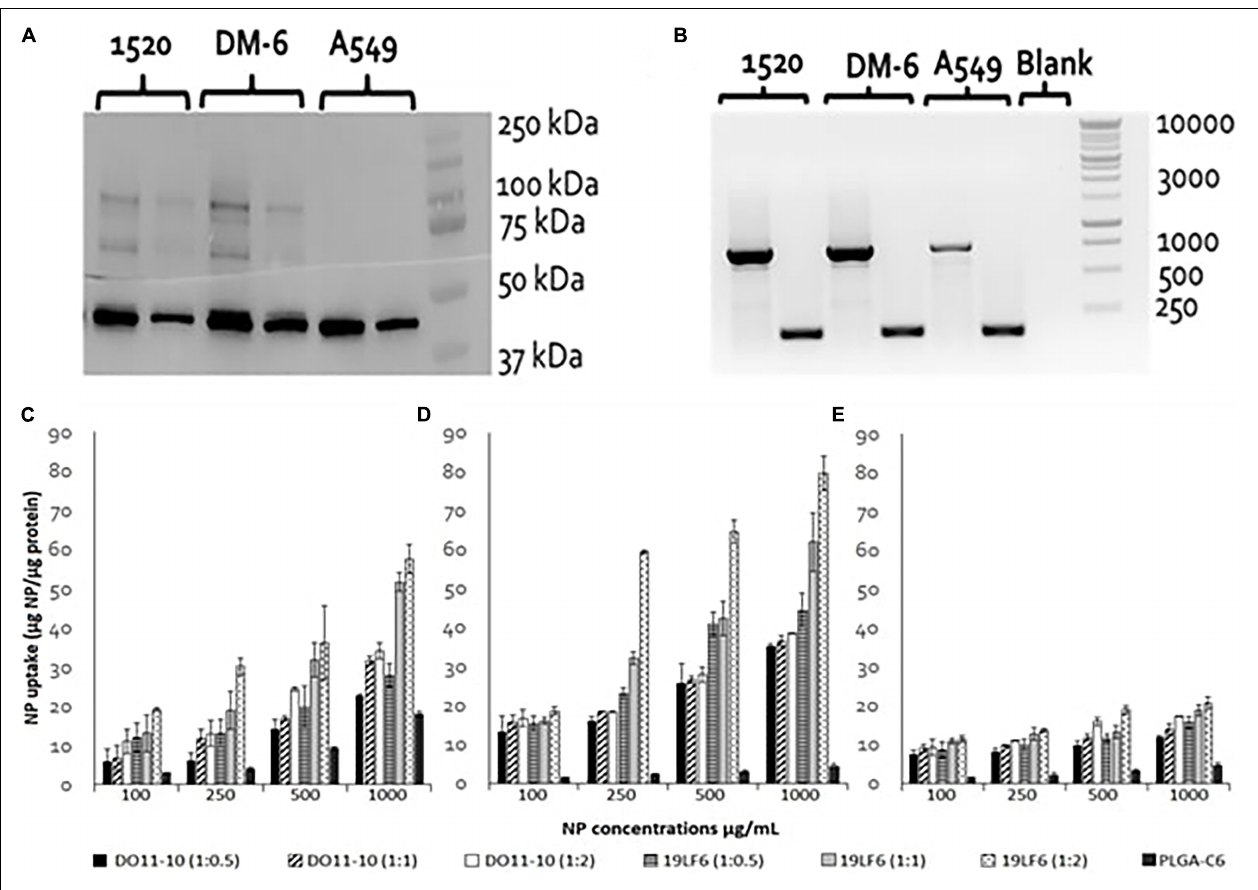
FIGURE 3 | gp100 expression and Cellular uptake of T-MNPs in different cell lines. (A) Western blot for assessing of gp100 protein content in 3 cancer cell lines: DM-6, 1520, and A549. β -actin was served as a control (42 kDa). Proteins are represented at two concentrations: 6 µ g (right) and 12 µ g (left) for each cell line. (B) RT-PCR: gp100 (751 bp) expression presented in 1520, DM-6, and A549 cell lines, β -actin served as a control (157 bp). (C) DM-6, (D) 1520, and (E) A549 cell lines were treated with MNPs for 2 h. Cell lysates were analyzed for MNP content using a UV-vis Spectrophotometer and cellular uptake was normalized with total cellular protein. Uptake of D-MNPs, T-MNPs and PLGA NPs (PLGA-C6) are presented at varying NP to membrane protein weight ratios. MNPs were loaded with a fluorescent dye, Coumarin 6 ( n =